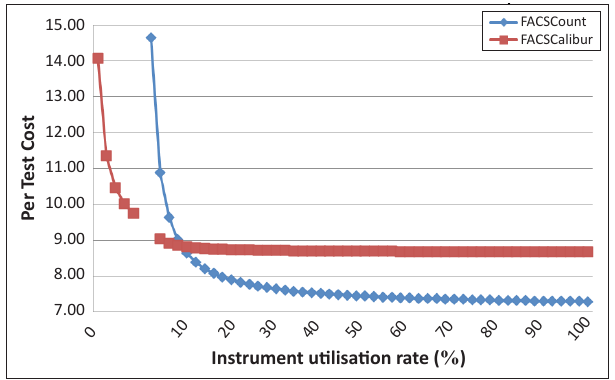
FIGURE 3: FACSCount™ versus FACCalibur™ utilisation price per test in US dollars. The reagent unit cost-per-test for the BD FACSCount ™ and BD FACSCalibur™ instruments was based on historical Partnership for Supply Chain Management (PFSCM) pricing and manufacturer-established consumption amounts, 7,8 using the reagents and consumption ratios in Table 1. Total costs were then calculated based on the product requirements needed to conduct CD4 testing over a one-day period. The rate of return diminishes to less than $0.01 per additional test added per day after a critical volume is achieved: FACSCount™, n > 20 tests or 40 % throughput; FACSCalibur™, n > 45 tests or 15 %